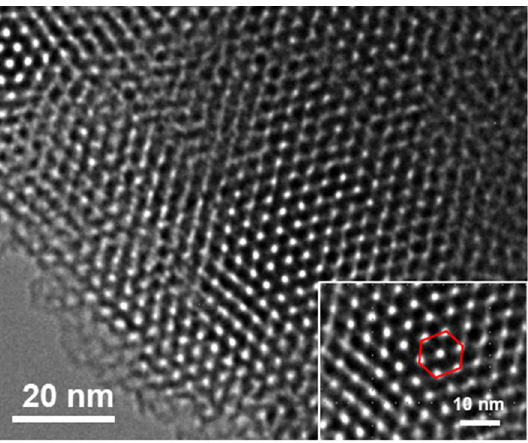
Figure 3. Top-view TEM image of NH 2 -VMSF at different magnification.